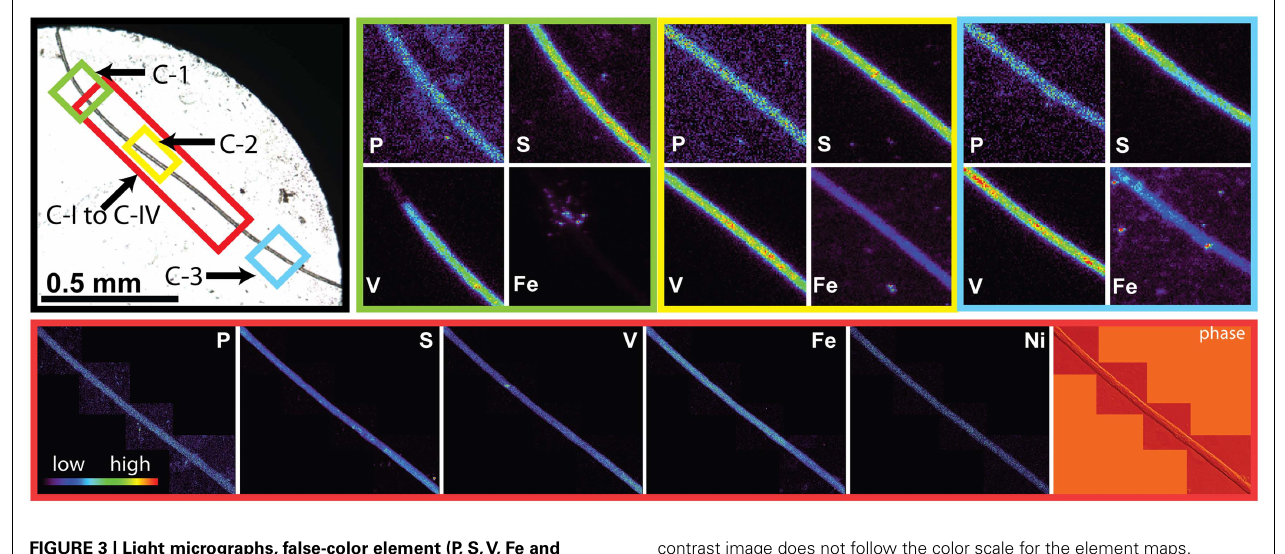
FIGURE 3 | Light micrographs, false-color element (P, S,V, Fe and Ni) maps, and differential phase contrast images (phase) (Hornberger et al., 2008) of Trichodesmium trichome C. The color scale for element maps is shown, with warmer colors indicating higher element concentrations.The color scheme of the differential phase